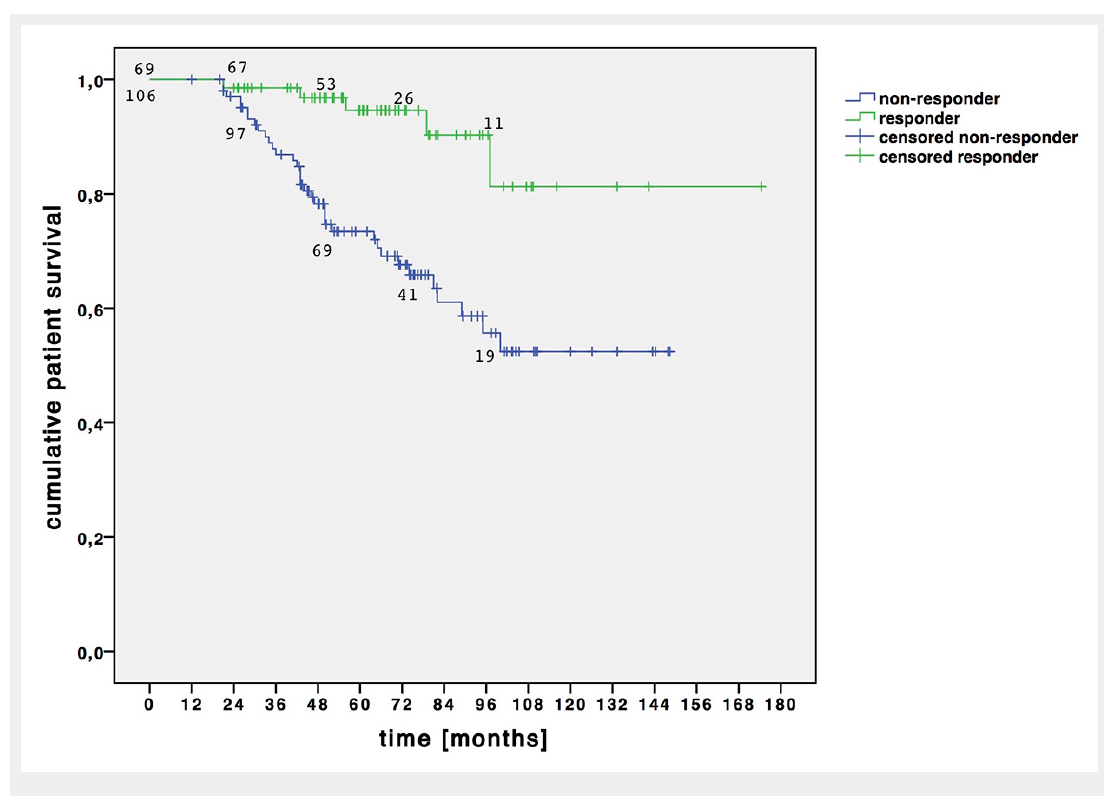
Figure 4 Kaplan-Meier curve of patient survival (NB: for inclusion into the study, patients had to survive for at least 2